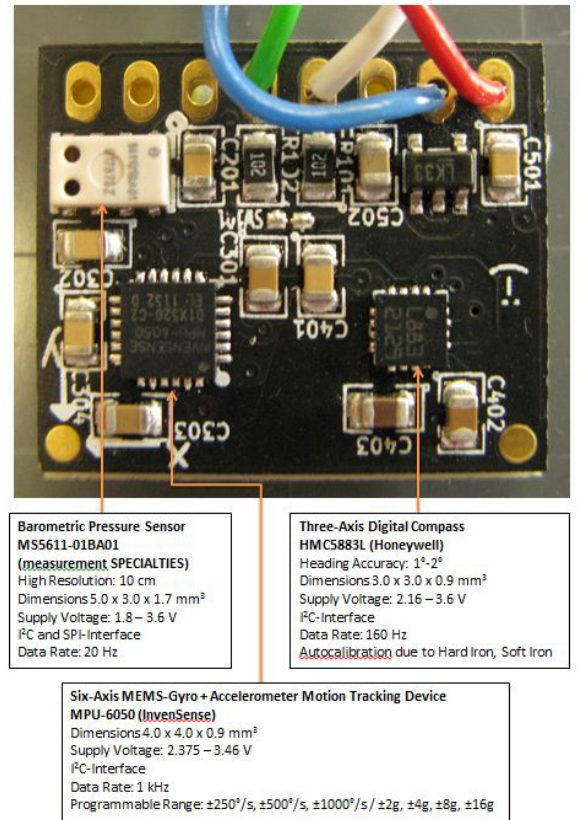
Figure 8. Multi sensor board with I²C-bus